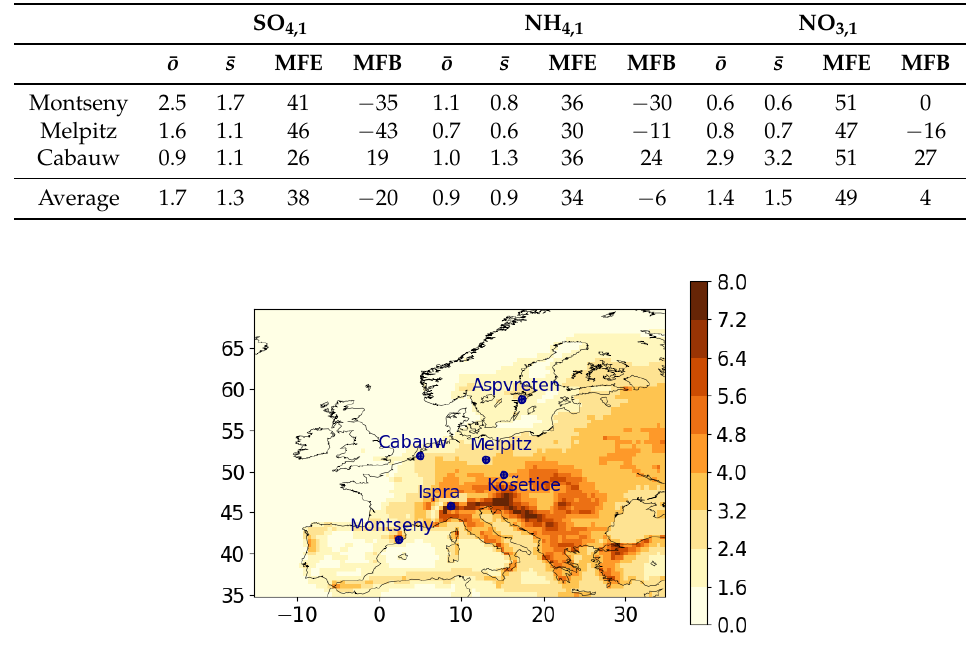
Table A4. Statistics (measured ¯ o and simulated ¯ s mean concentrations ( µ g m − 3 ), mean fractional error MFE (%) and mean fractional bias MFB (%)) of comparisons to measurements for daily concentrations of SO 4,1 and NH 4,1 and NO 3,1 .